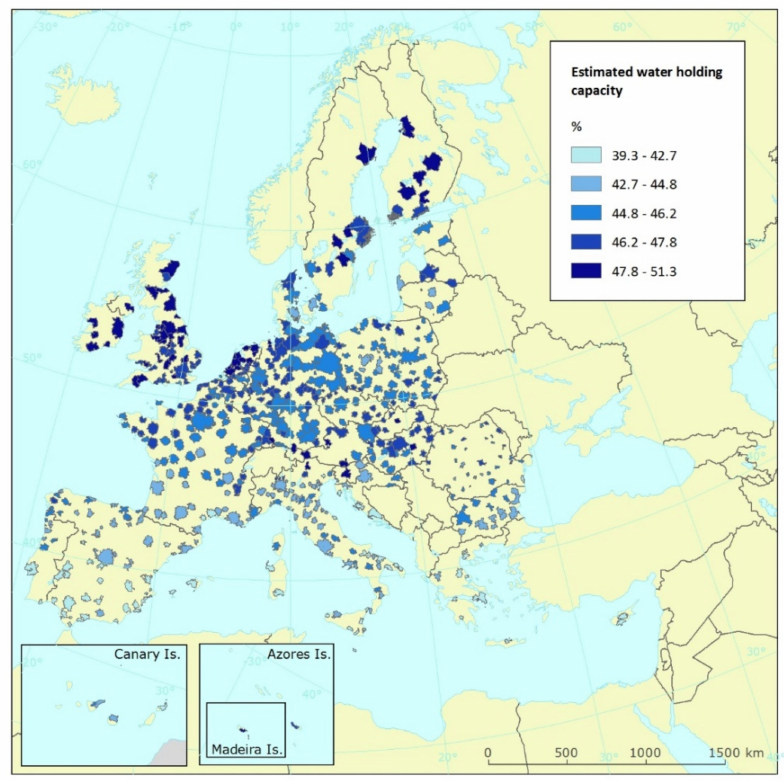
Figure 7. Estimated water holding capacity of soils in Functional Urban Areas.